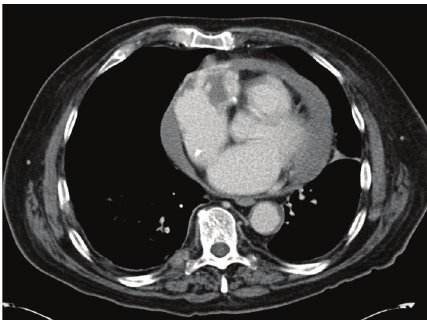
Figure 2: Computed tomography scan of the chest showing the right atrial mass and pericardial e ff usion.